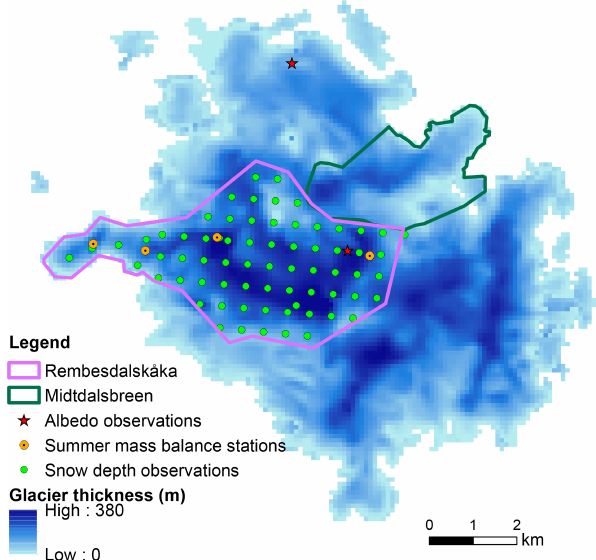
Figure 1. Glacier thickness and present extent for Hardanger- jøkulen. The outlet glaciers, Rembesdalskåka and Midtdalsbreen, are also indicated. The green dots indicate locations where stake observations for winter balance were obtained, while orange dots indicate location of observations for summer balance. Stars shows location of albedo comparison with model against